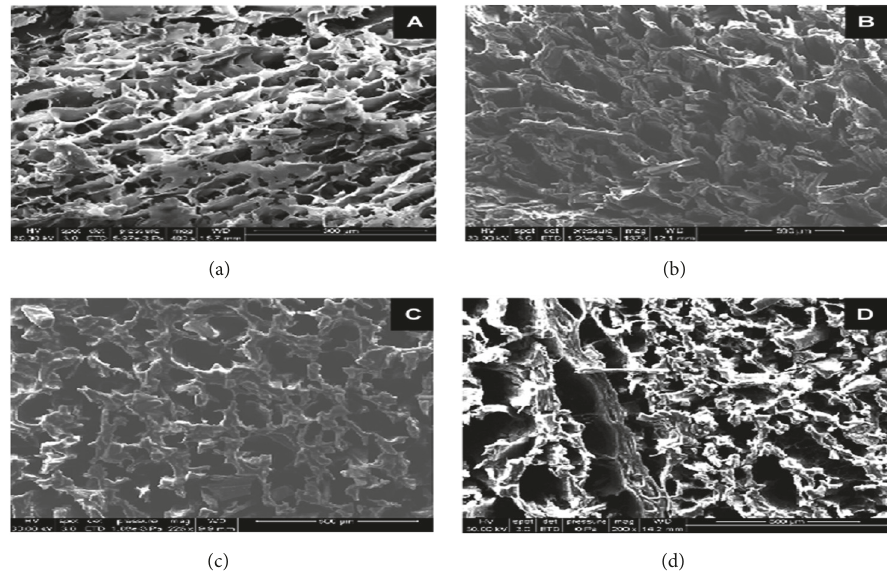
Figure 6: Environmental scanning electron microscopy of freeze-dried salmon. Before freeze-drying, frozen salmon was subjected to state transitions during 4 weeks’ storage. (a) Immediately after freezing, (b) T < -27 ∘ C(-17 ∘ F); (c) -27 ∘ C(-17 ∘ F) < T < 17 ∘ C(1 ∘ F); (d) T > 17 ∘ C(1 ∘ F) (Figure 6 is reproduced from [22] [under the Creative Commons Attribution License/public